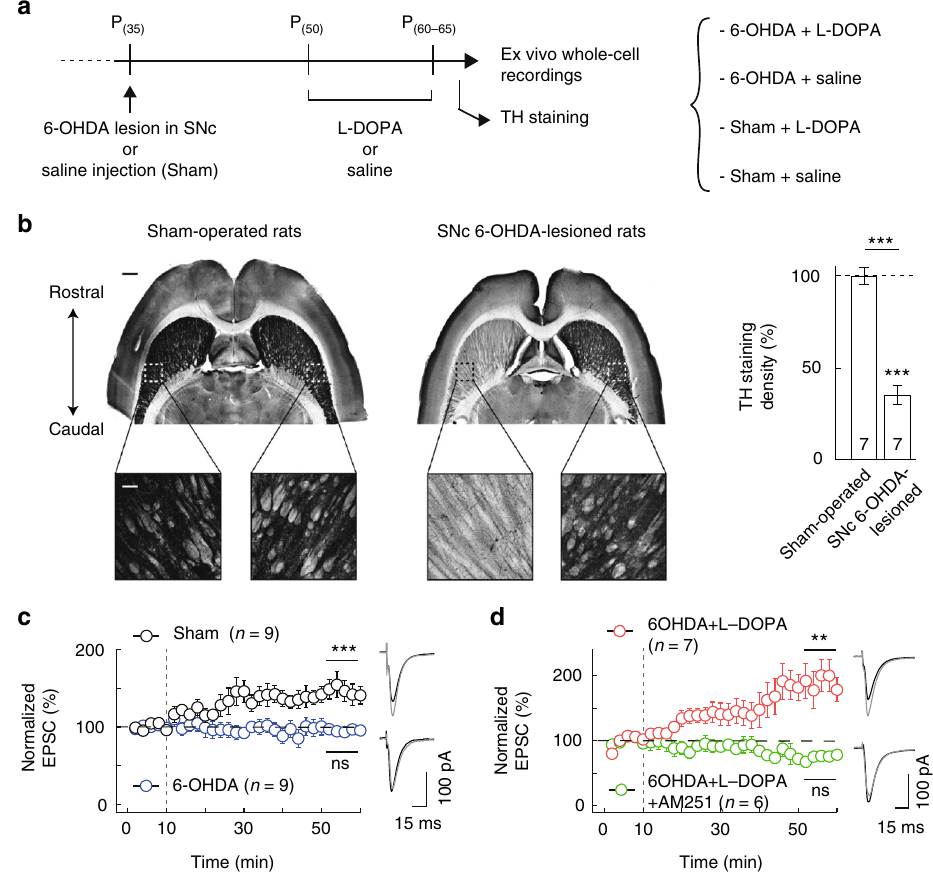
Fig. 2 eCB-tLTP is impaired in a rat model of Parkinson ’ s and rescued by L-DOPA. a Protocols of the 6-OHDA lesion (or sham) in P 35 rats followed 2 weeks after by chronic L-DOPA treatment (or saline) for 10 days. b Unilateral 6-OHDA injection in SNc led to degeneration of dopaminergic nigral neurons and a loss of their striatal afferences as illustrating by TH immunostaining in horizontal brain slices. Note that sham-operated rats display equivalent TH staining in both striata. Scale bars: 1 mm and 200 µ m. Right panel: summary bar graph of TH staining quanti fi cation. c 10 post-pre pairings induced eCB-tLTP in sham-operated rats ( n = 9, 9/9 cells showed tLTP) while no plasticity was observed in 6-OHDA-lesioned rats ( n = 9, 1/9 cells showed tLTP). d Chronic L-DOPA treatment consisting in twice daily injection of L-DOPA (10 mg/kg) for 10 days, 2 weeks after 6-OHDA lesion allowed to recover tLTP ( n = 7, 6/7 cells showed tLTP) induced with 10 post-pre pairings. This tLTP was CB 1 R-mediated since prevented by AM251 (3 µ m, n = 6, 0/6 cells showed tLTP) in 6-OHDA-lesioned rats treated with L-DOPA. Representative traces are the average of 15 EPSCs during baseline (black traces) and 45 min after STDP protocol (grey traces). Vertical grey dashed line indicates the STDP protocol. Error bars represent sem. ** p < 0.01; *** p < 0.001; ns: not signi fi cant by one sample t -test ( c , d ) or Wilcoxon Signed rank test ( b